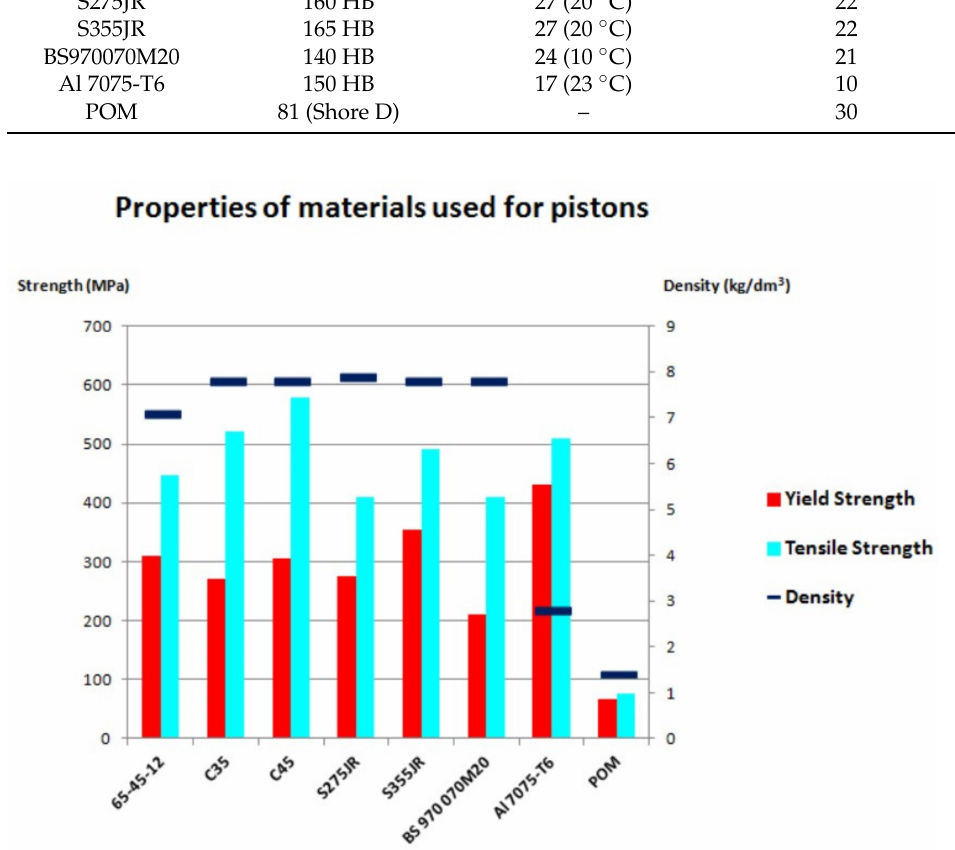
Figure 7. Chart of properties of the materials used for the